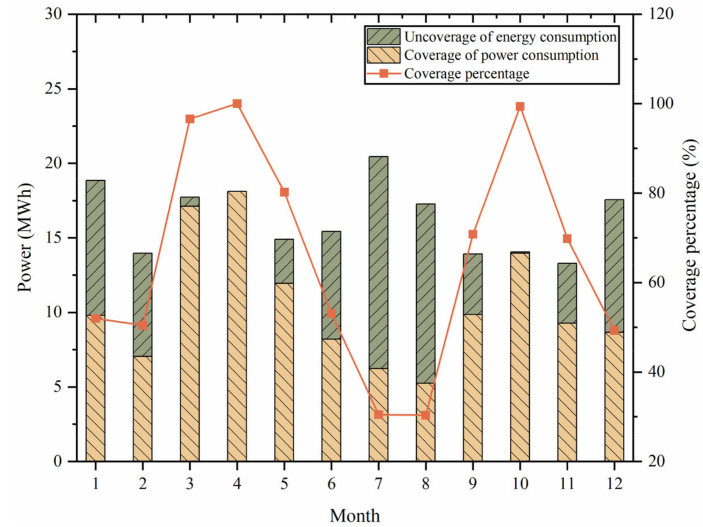
Figure 13. Power consumption coverage by PV/T in the system.